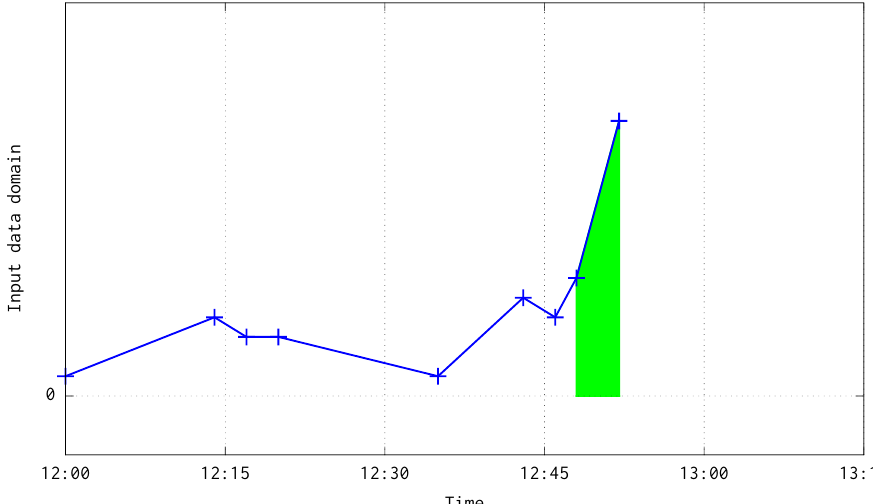
Figure 4. Illustration about the integration process of previous and current input data pairs.